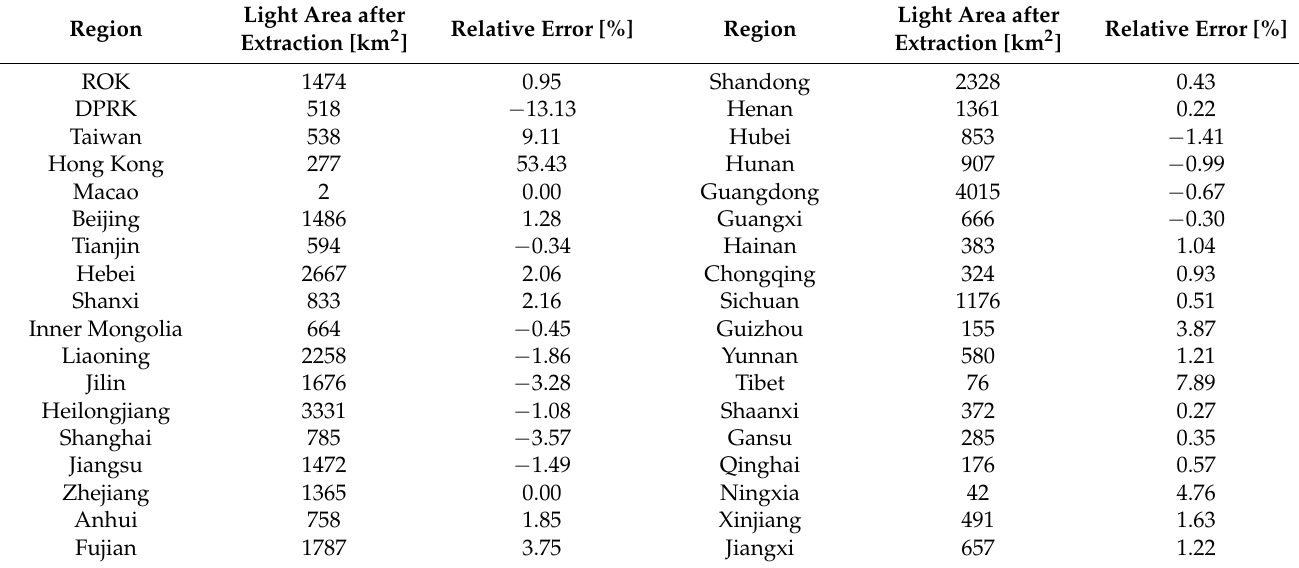
Table 2. Results for optimal error threshold for DPRK, China, and Republic of Korea (ROK), and error